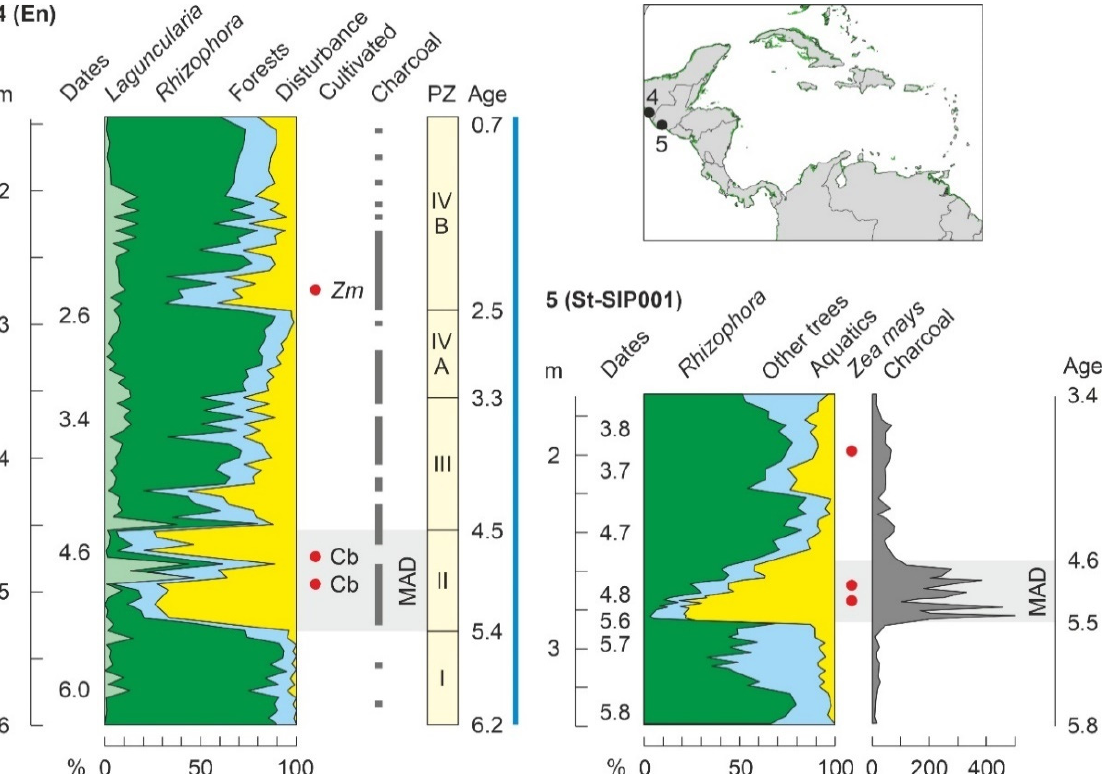
Figure 17. Summary subcentennial pollen records from Mesoamerica showing the conspicuous Mesoamerican Archaic Disturbance event (MAD) (gray band). The occurrence of pollen from cultivated plants is indicated by red dots (Cb, Cucurbitaceae; Zm , Zea mays ). All dates (calibrated from 14 C dates) and ages (interpolated/extrapolated from age-depth models) are in cal kyr BP and have been taken from the original references. Charcoal is represented in concentration units (particles/mL of sediment). PZ, pollen zones. Redrawn and composed from Refs. [124,178].